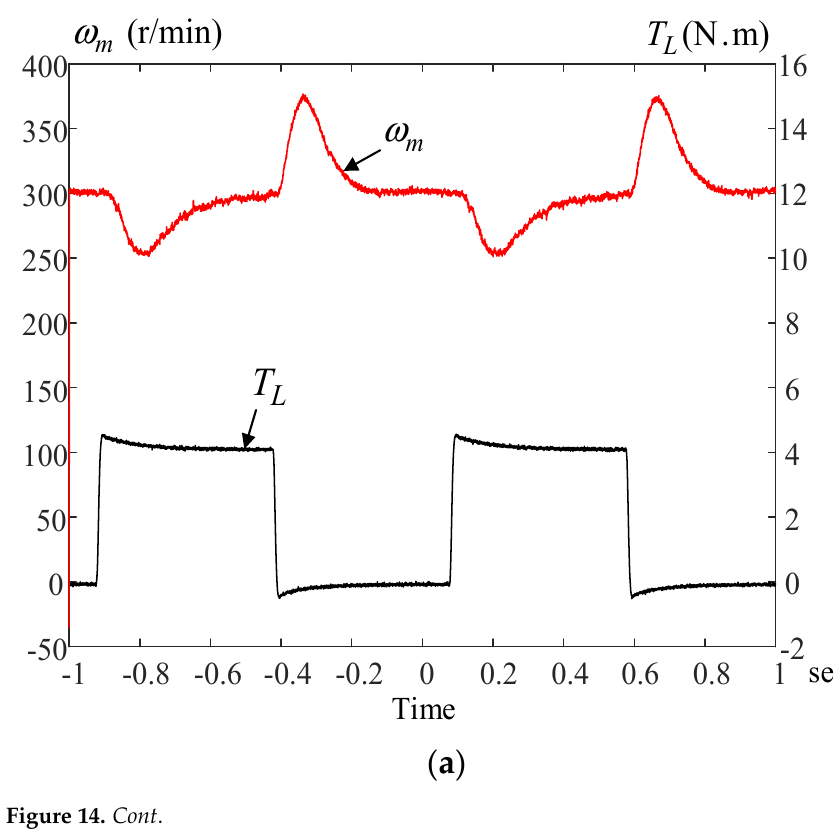
Figure 13. The measured sinusoidal speed responses: ( a ) responses; ( b ) tracking errors.